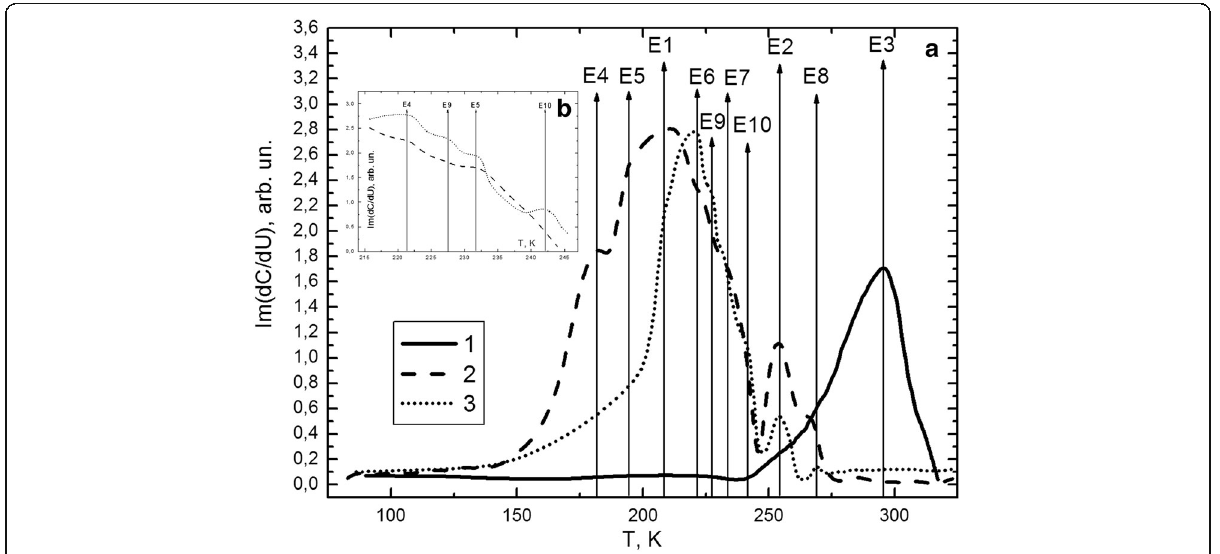
Fig. 5 Capacitive-modulation spectrum of deep levels in the bandgap of silicon of samples at a frequency of 500 Hz ( a ): 1 initial sample of p-type silicon, 2 plastically deformed sample with the concentration of dislocations N d ≈ 10 7 cm -2 , 3 plastically deformed sample that was subjected to additional high temperature annealing. b DLCMS graph zoomed in a range of temperatures from 215 to 245